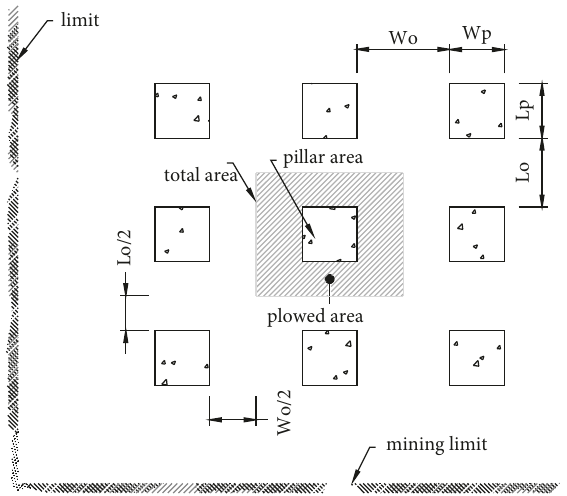
Figure 3: Arrangement of mining via room and pillars method: ‘plan